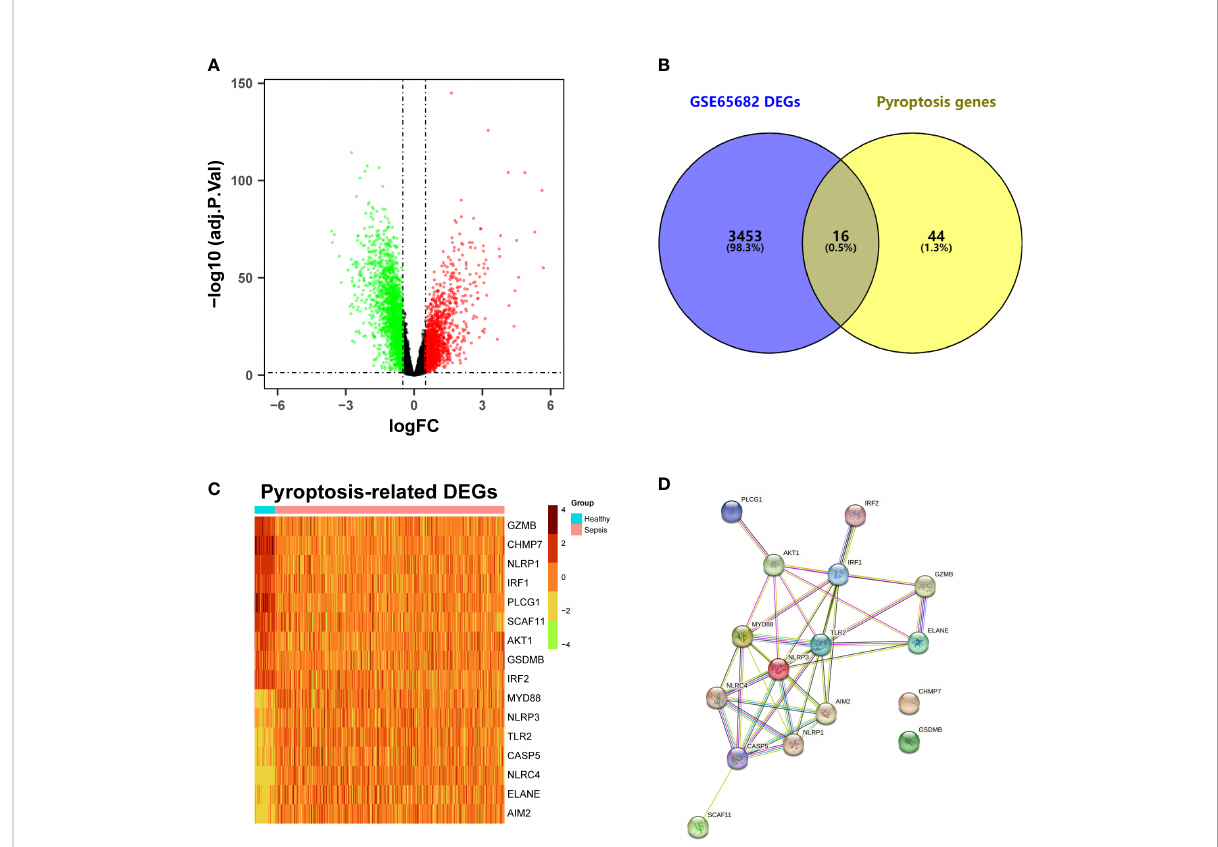
FIGURE 1 Identi fi cation of differentially expressed pyroptosis-related genes and interaction. (A) Volcano plot of DEGs in the GSE65682 dataset between sepsis patients and healthy individuals. (B) Venn plot of the DEGs and pyroptosis genes. (C) Heatmap of pyroptosis-related DEGs. (D) Protein- protein interaction (PPI) network analysis of proteins encoded by the pyroptosis-related